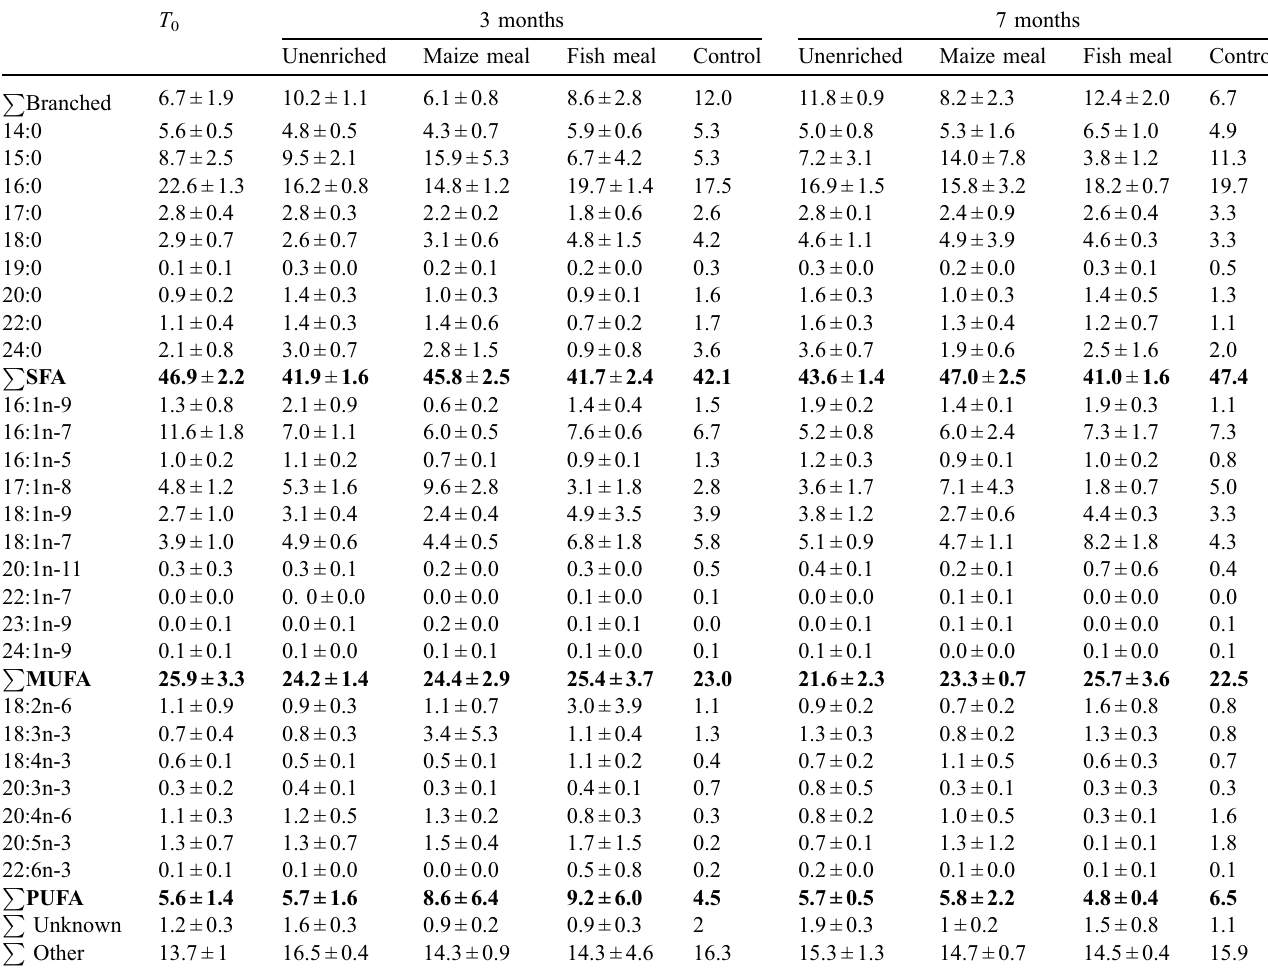
Table 1. Fatty acid composition (mass % of total FA, mean ±S.D.) of sediment from the different treatments at the beginning of the experiment (T 0 ), after 3 month, and after 7 months ( n =3 for each time). SFA: saturated FA; MUFA: monounsaturated FA; PUFA: polyunsaturated FA; Branched: FA [15iso þ 15anteiso þ 16iso þ 17iso þ